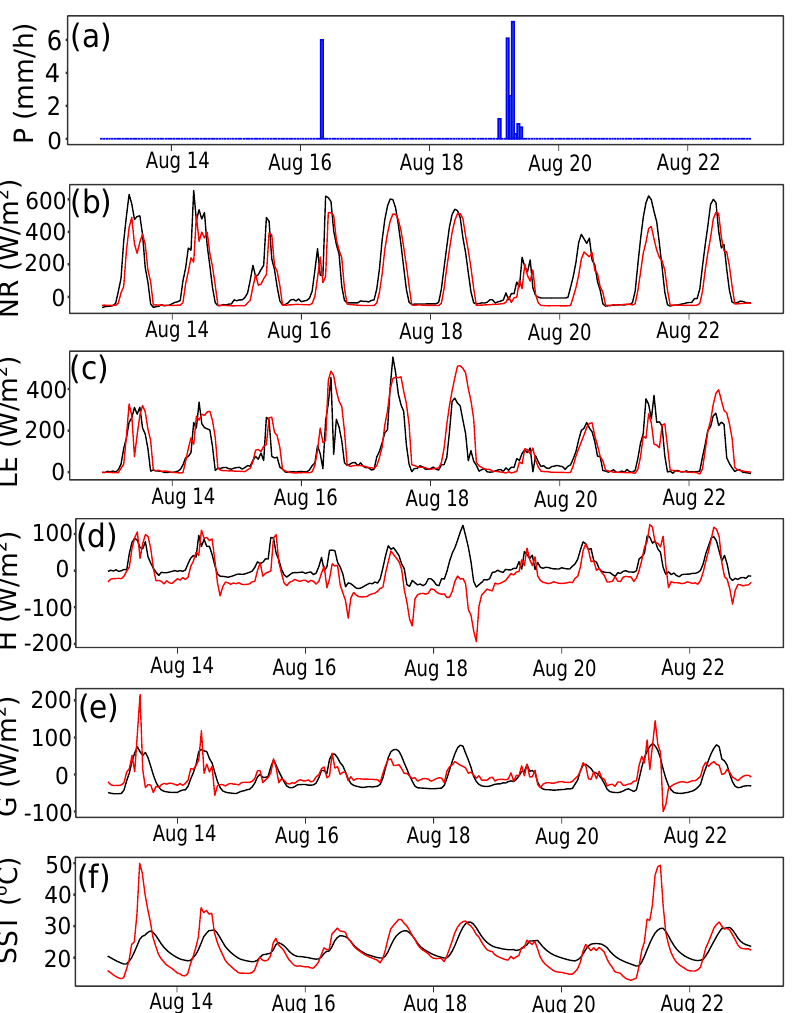
Figure 9. Hourly time series of ( a ) observed precipitation (P; blue bars), ( b ) simulated (red) and observed (black) net radiation (NR, W/m 2 ), ( c ) latent heat flux (LE, W/m 2 ), ( d ) sensible heat flux (H, W/m 2 ), ( e ) ground heat flux (G, W/m 2 ), and ( f ) soil surface temperature (SST, ◦ C) at ARM-CF during a ten-day period in 2004 between 12 August and 22